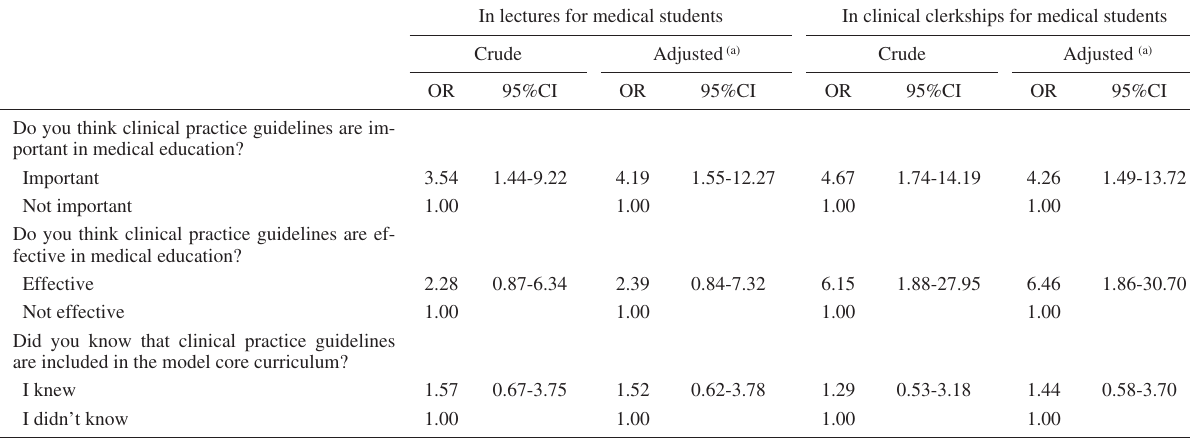
Table 2. The cross-sectional association between the recognition and use of clinical practice guidelines in medical education among doc- tors (n =